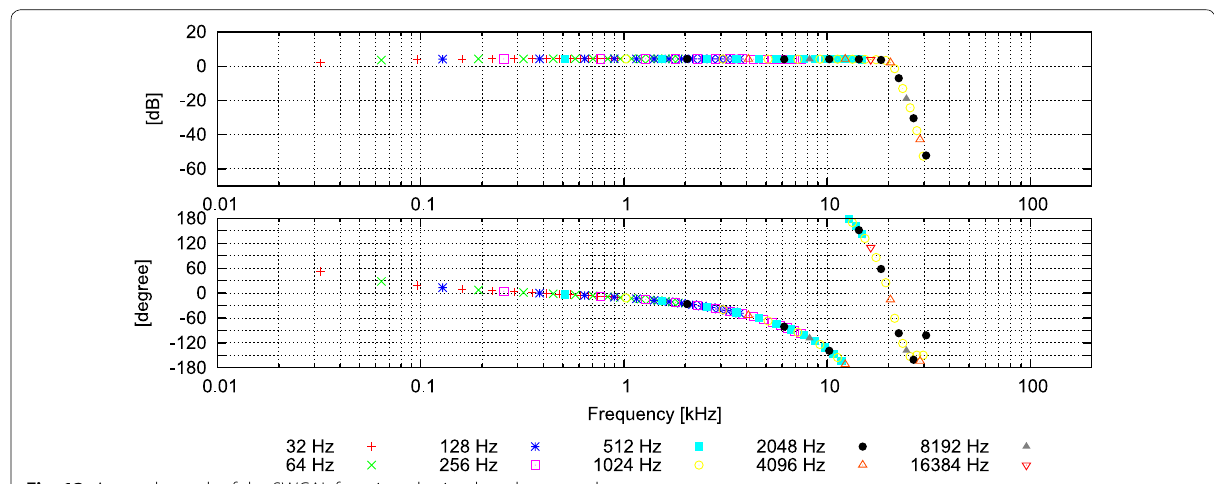
Fig. 13 A sample result of the SWCAL function obtained on the